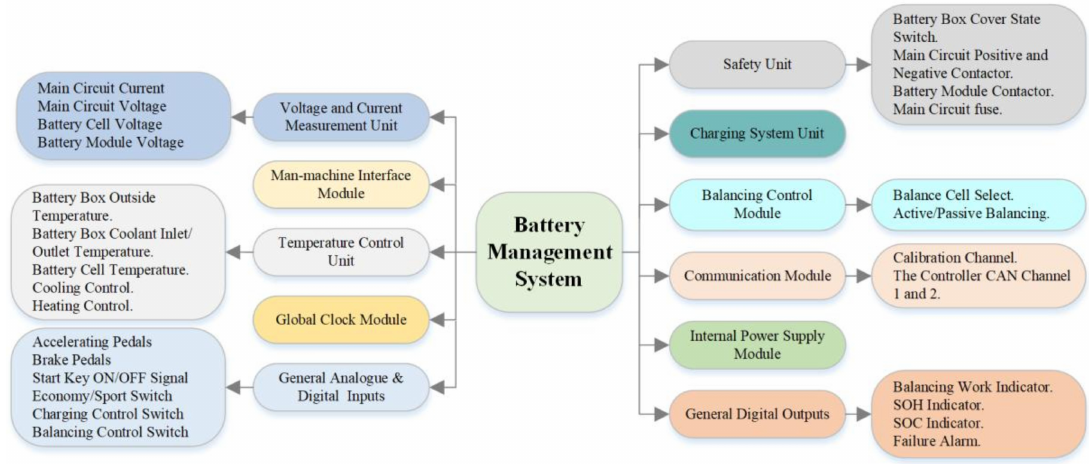
Figure A1. Comprehensive framework for an effective